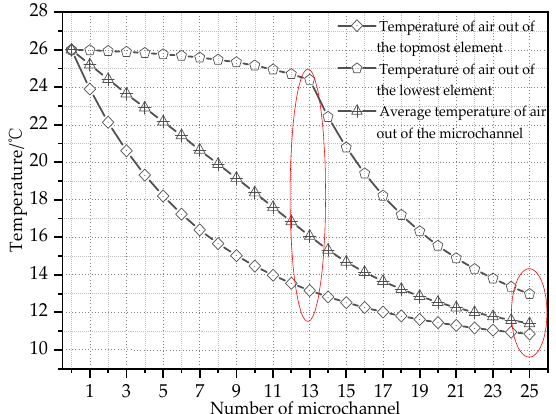
Figure 16. Air temperature change in the airflow direction.